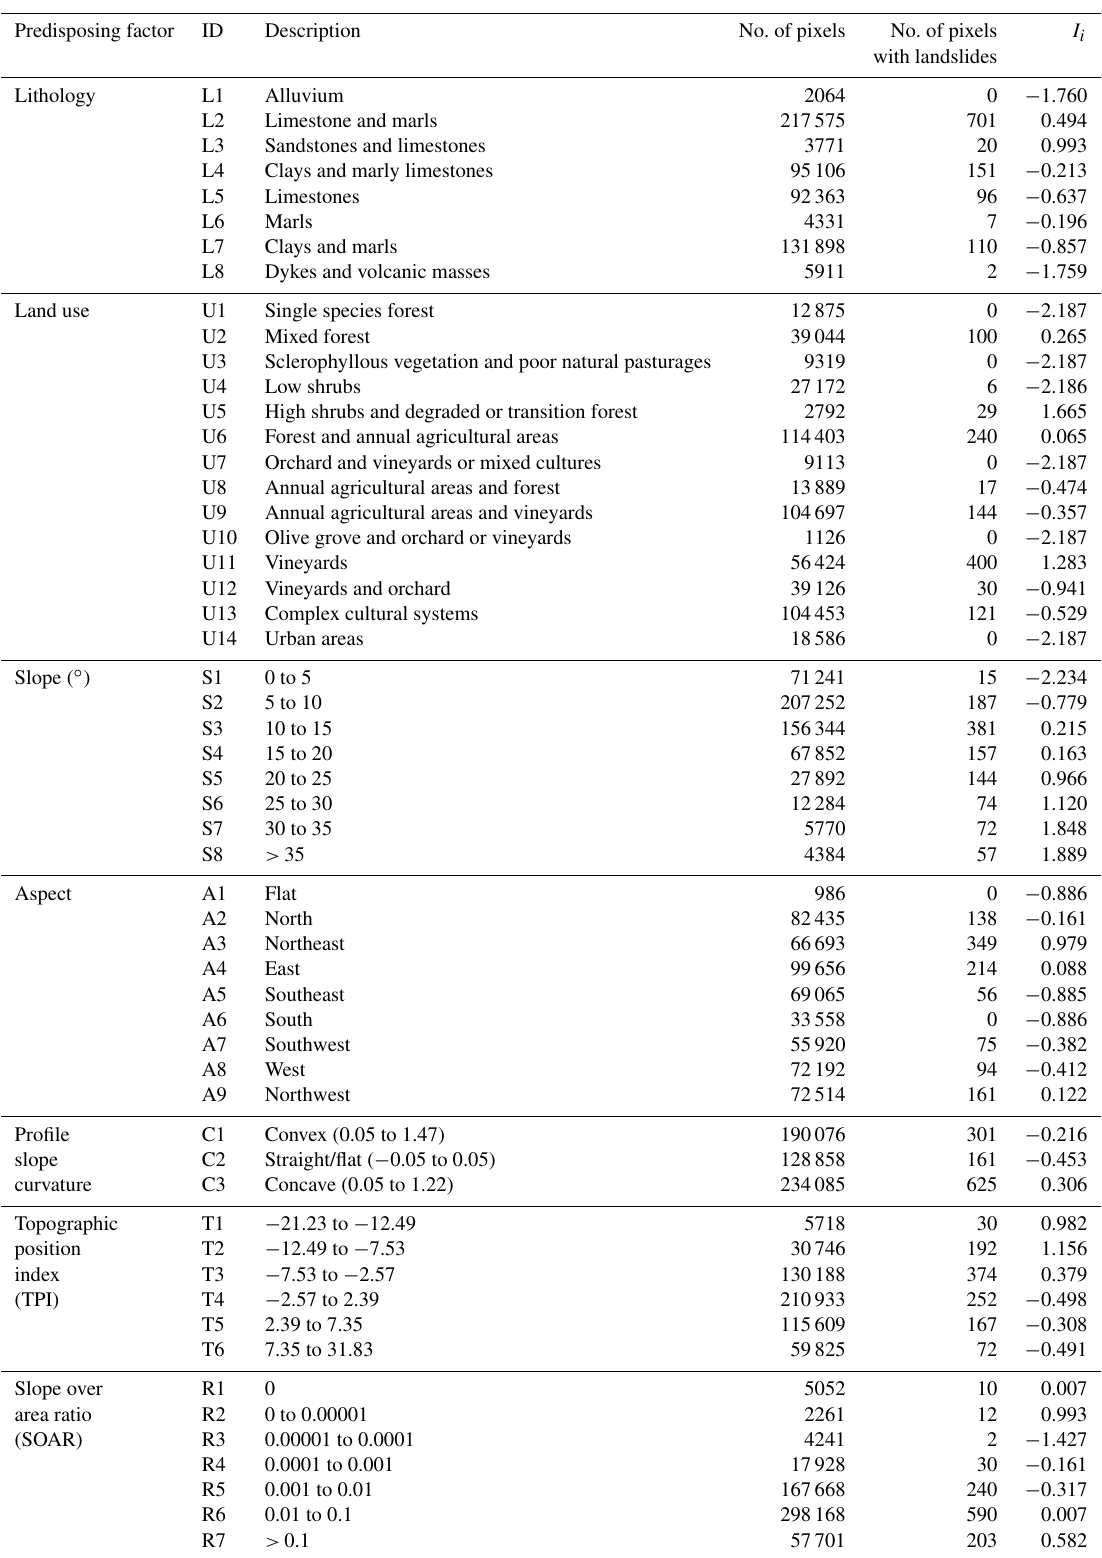
Table 2. Description of landslide predisposing factor classes and respective information value scores ( I i ). Predisposing factor ID Description No. of pixels